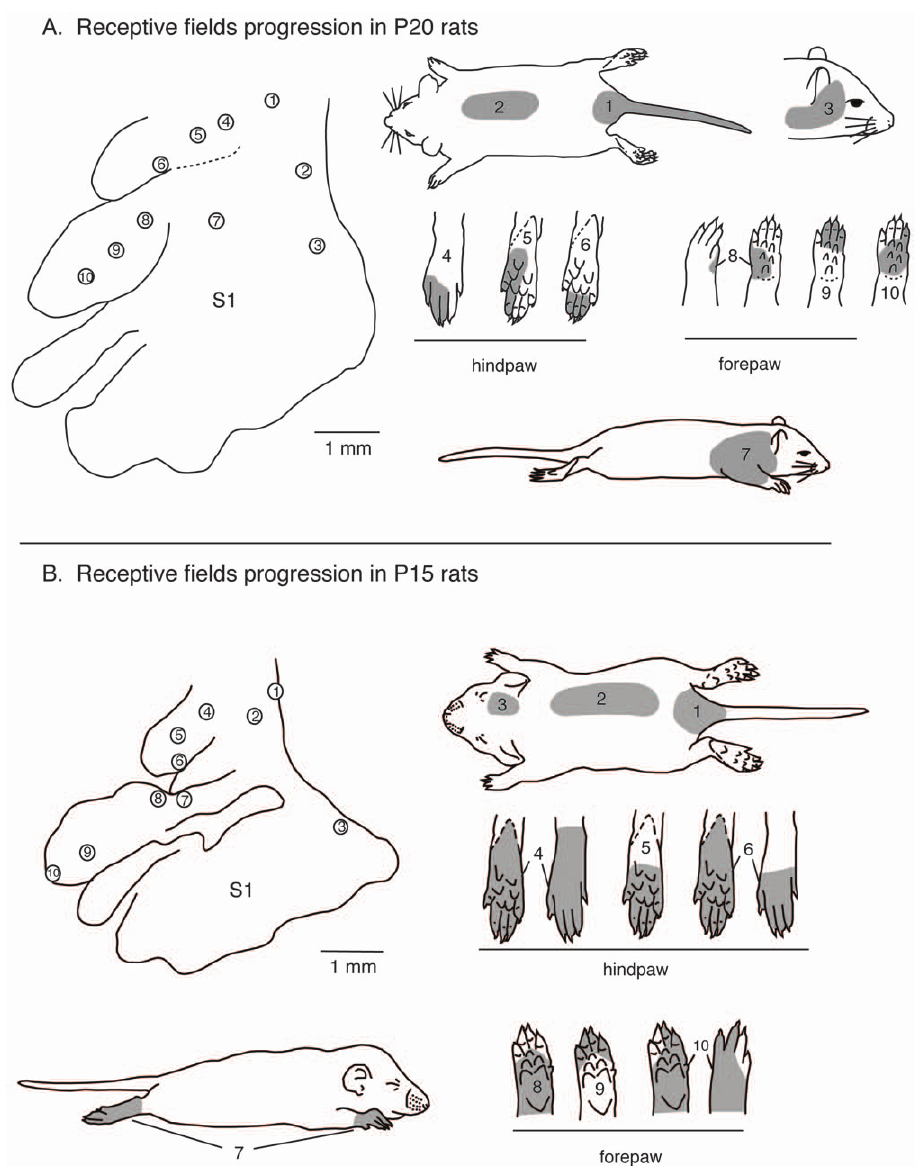
Figure 12. Receptive field progressions in P20 and P15 rats. A) Progressions of recording sites in S1 in a P20 rat (left) and corresponding receptive fields for neurons at those sites (right). In P20 rats, the topographic organization is similar to that seen in adults. As recording sites progress from medial to lateral in the caudal portion of S1 (sites 1–3) corresponding receptive fields move from the tail, hindlimb and lower trunk to upper trunk and face. Compared to adults, receptive fields on the hindpaw (4–6) and forepaw (8–10) are larger and can encompass multiple digits, toes, or pads. B) Progressions of recording sites in S1 in a P15 rat (left) and corresponding receptive fields for neurons at those sites (right). In P15 rats the topographic representation is less well-organized and there is greater variability between animals. Receptive fields are larger and can encompass more than one body part (i.e., site 7). As recording sites progress from medial to lateral in the caudal portion of S1 (1–3) corresponding receptive fields move from the tail and lower trunk, to the middle trunk and head. Most often receptive fields are on the entire foot (4–5) or large portions